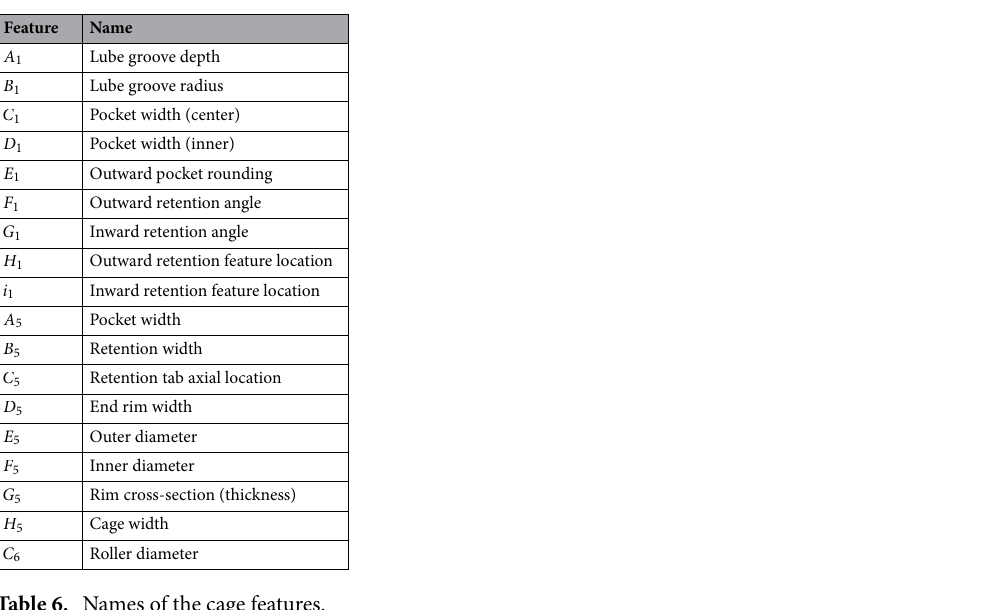
Table 6. Names of the cage